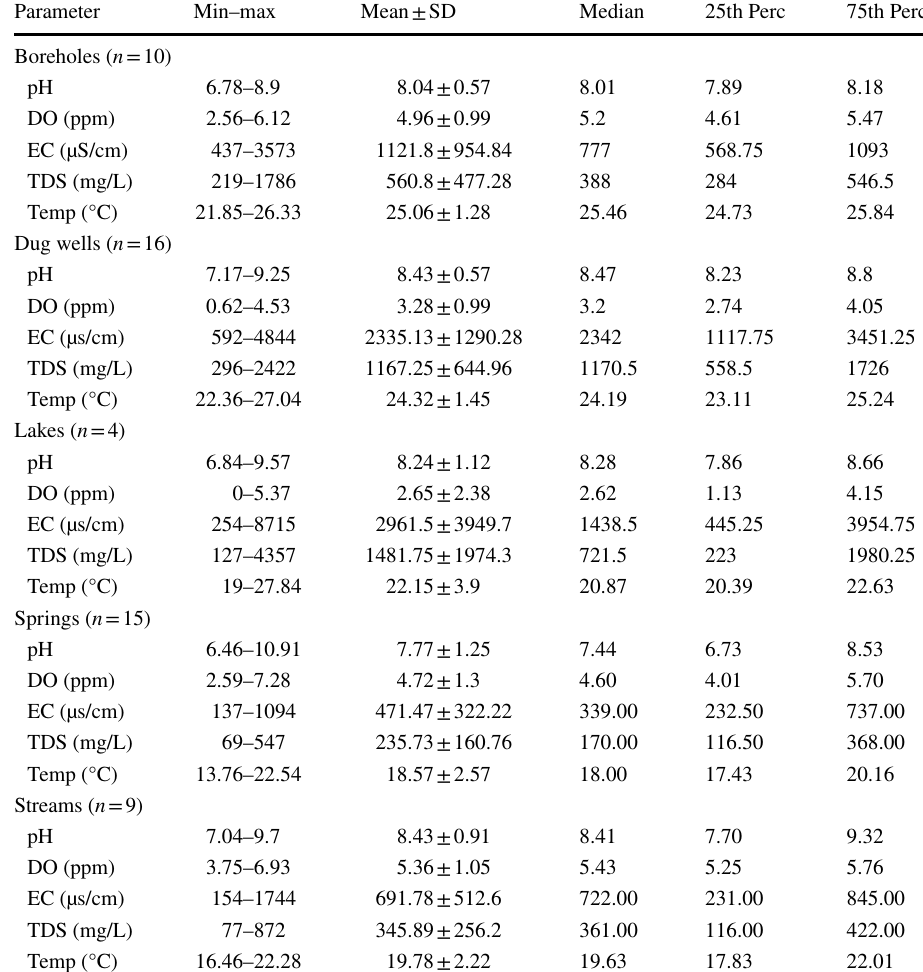
Table 1 Statistical summary of physicochemical